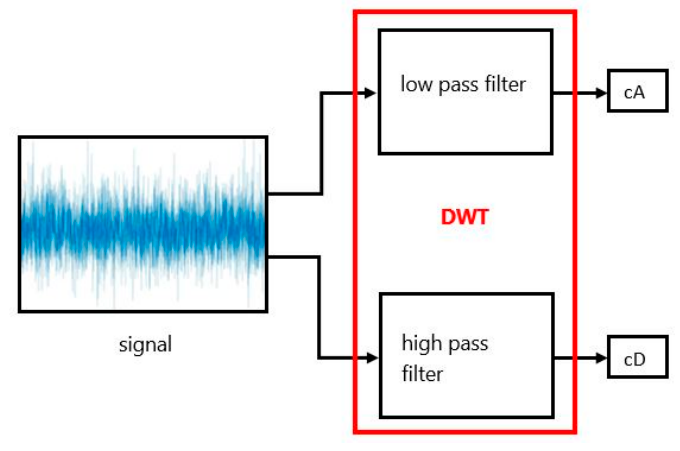
Figure 2. Filtering in one level of one-dimensional (1-D) DWT.